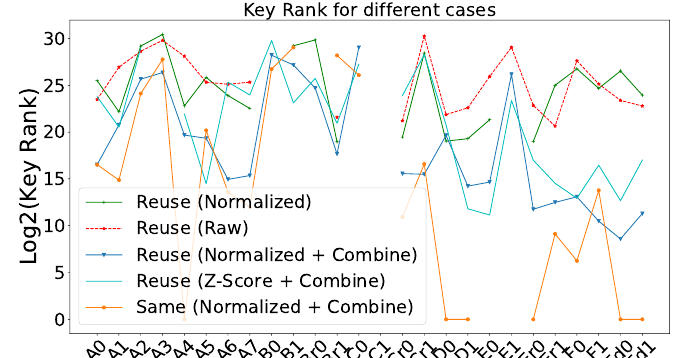
Figure 11: Key rank for different devices and collection campaigns. The baseline (orange) shows the best case (attacking and profiling the same device, normalized traces, average of the 16 bytes as explained in Section 2.6.3). The other lines show the key rank when using the attack traces of device A0 (first acquisition) with each of the other profiles. In most cases, the key rank shows a moderate increase, which is in the same order of magnitude for time and device changes. Missing points correspond to a key rank bigger than 2 30 . Our per-trace normalization (blue) has similar results that z-score normalization of the set (cyan).